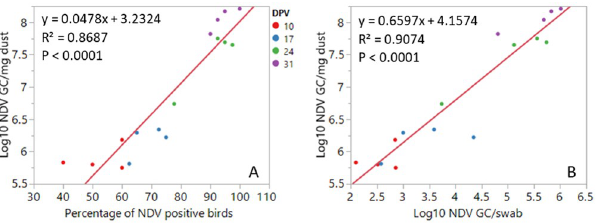
Fig 1. Linear association of log 10 NDV GC in dust with the percentage of NDV positive birds in swabs (A) and log 10 NDV GC in swabs (B). Each data point represents the mean value for each one of the four poulty houses on a given